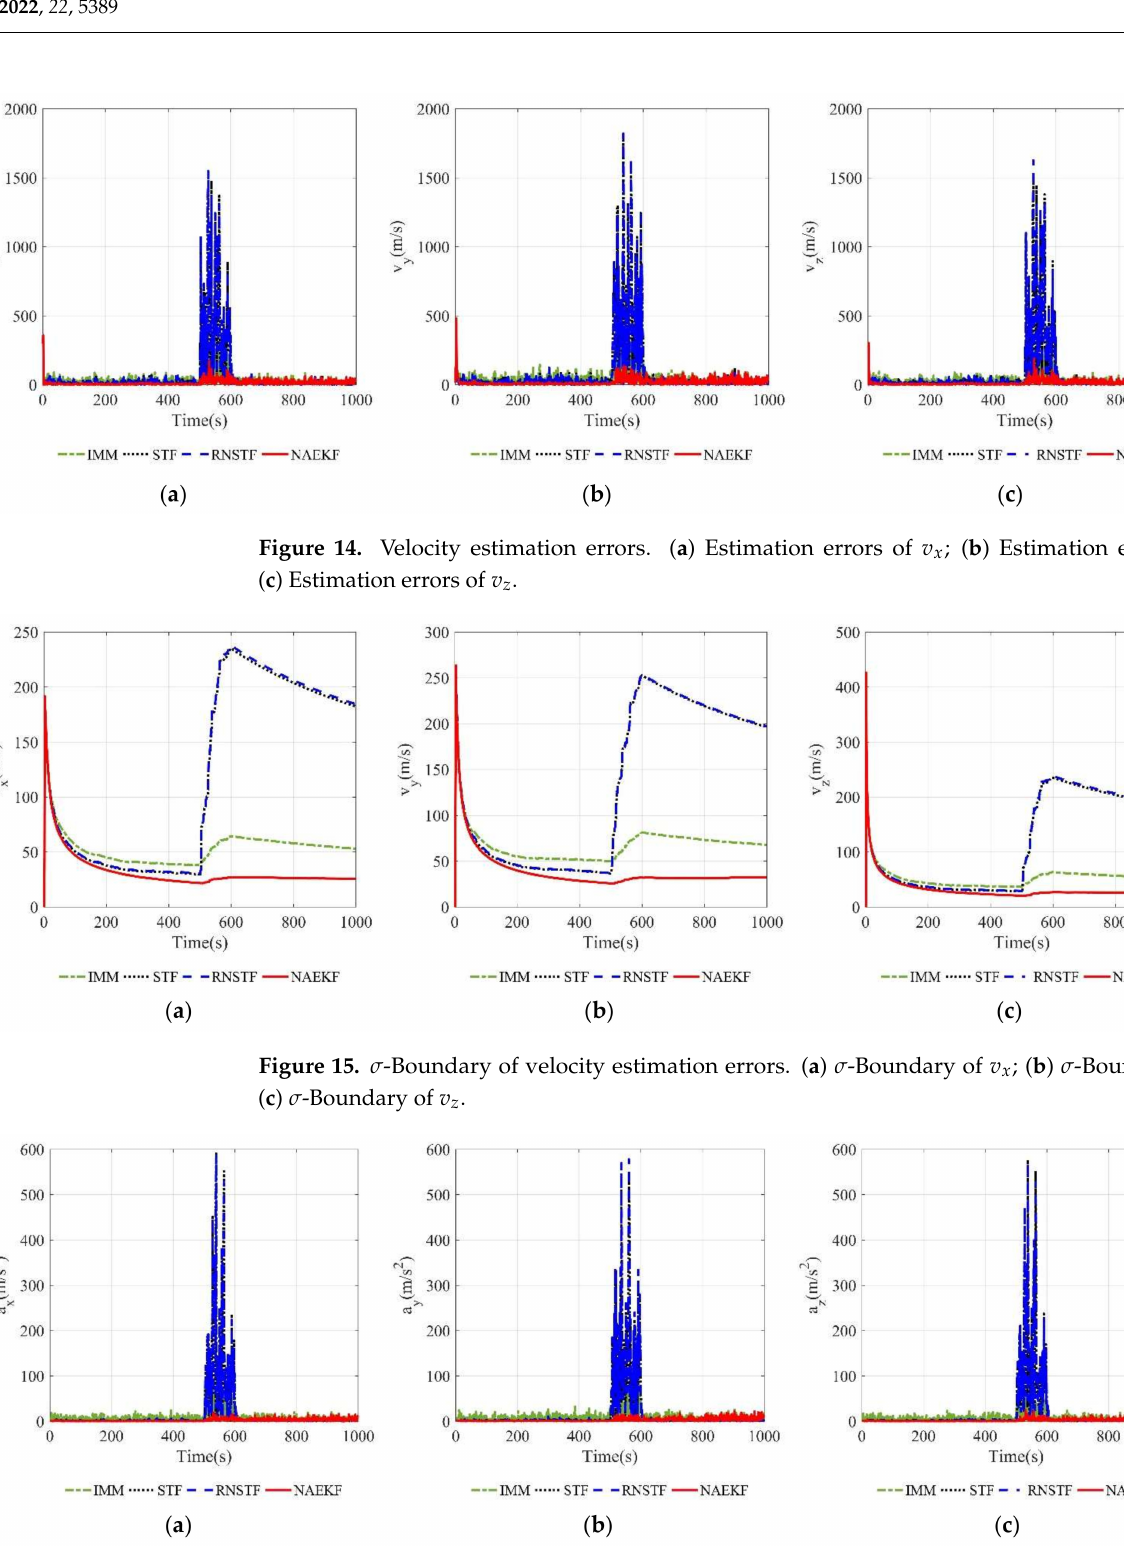
Figure 16. Acceleration estimation errors. ( a ) Estimation errors of a x ; ( b ) Estimation errors of a y ; ( c ) Estimation errors of a z